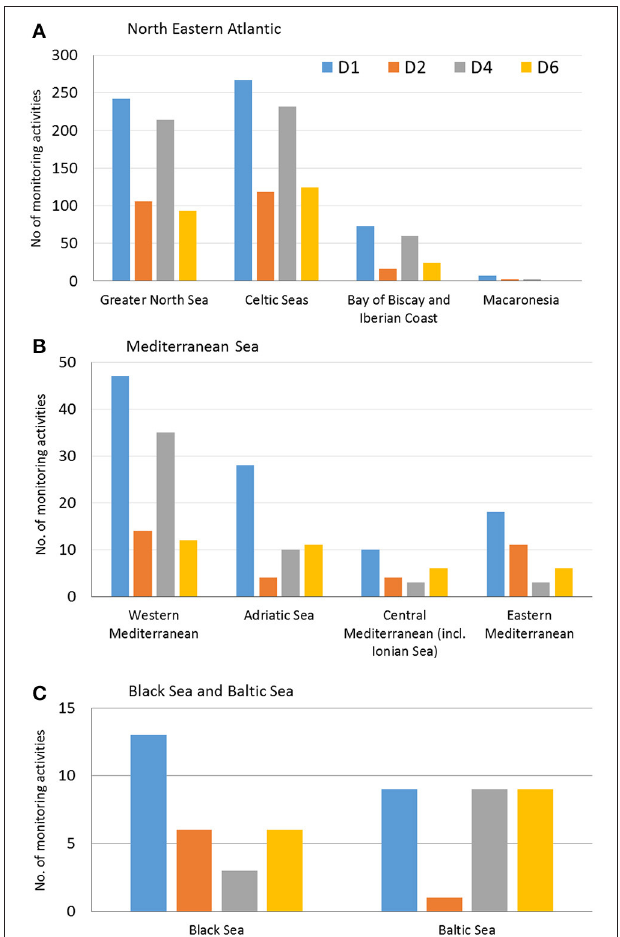
FIGURE 4 | Number of monitoring activities per MSFD Descriptor. D1, biological diversity, D2, non-indigenous species; D4, food webs; D6, seafloor integrity, in (A) . the North Eastern Atlantic sub-regions, (B) . Mediterranean Sea sub-regions and (C) . Black Sea and Baltic Sea.